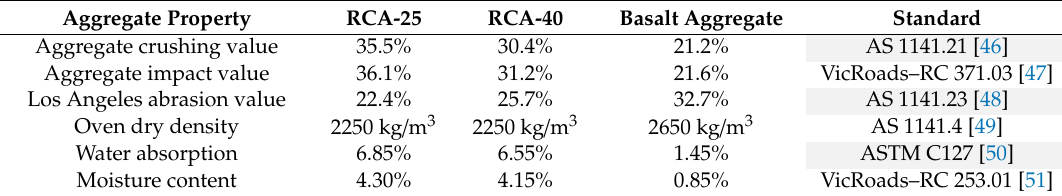
Table 3. Properties of coarse